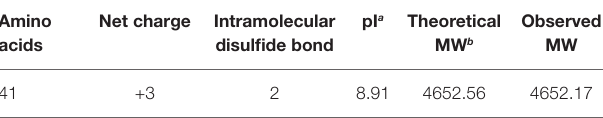
TABLE 1 | Physico-chemical parameters of topmouth culter LEAP-2. Amino